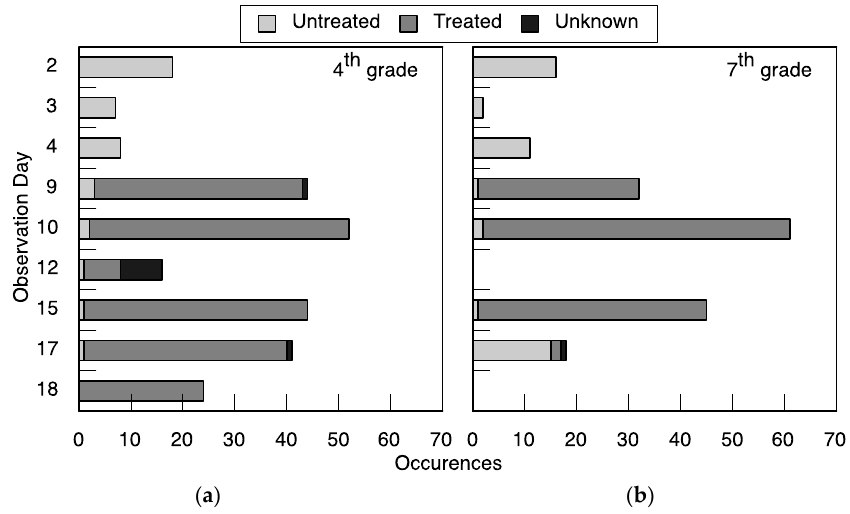
Figure 8. Results from ( a ) fourth grade and ( b ) seventh grade observation study in community